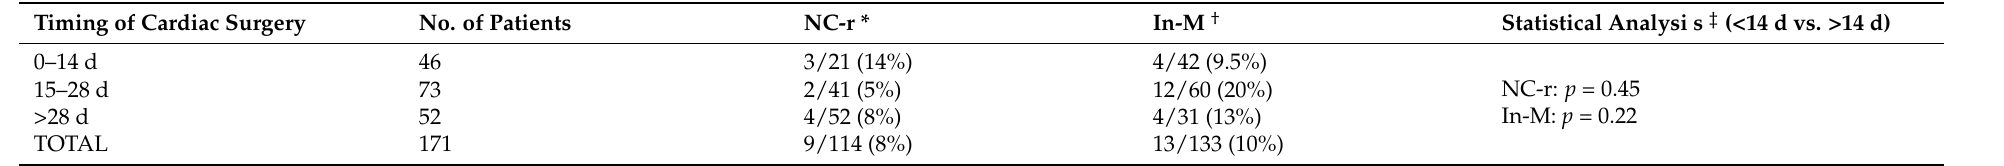
Table 3. Summary of results reported in the studies listed in Table 2 of patients with infective endocarditis and hemorrhagic neurological complication undergoing cardiac surgery.